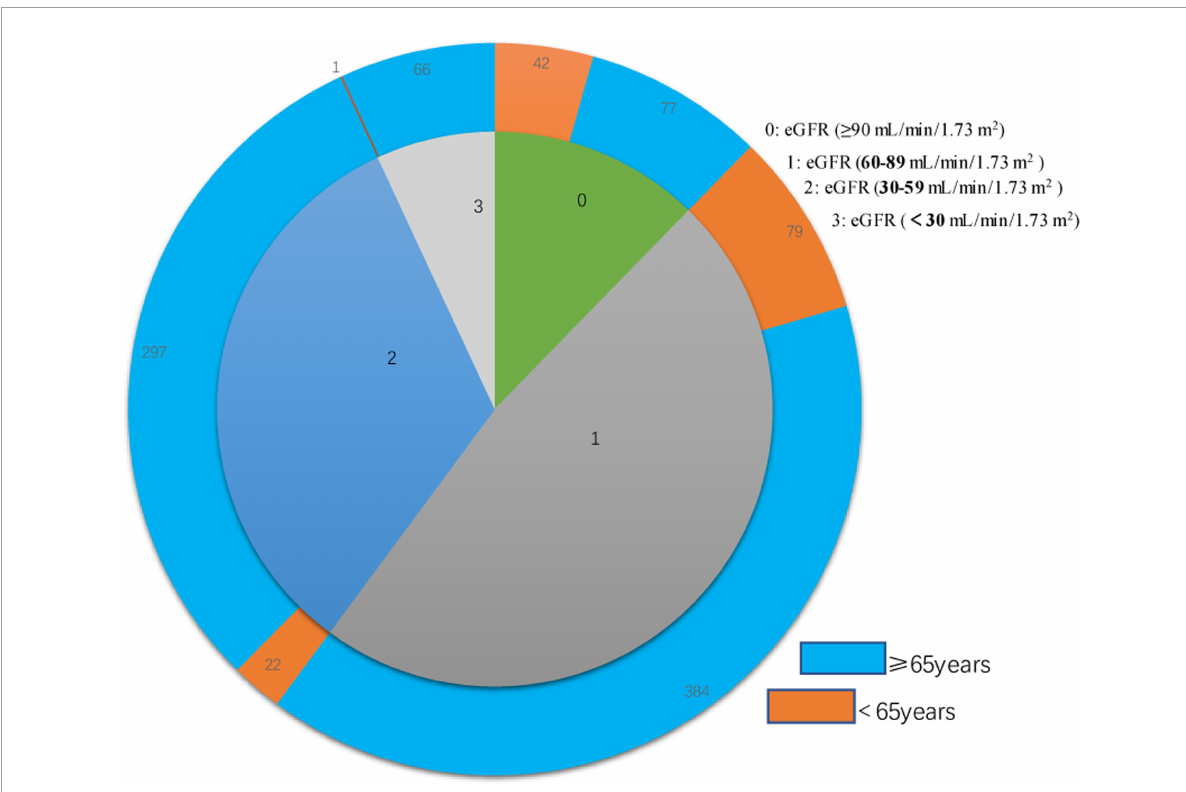
FIGURE1 Double layer pie chart showing the numbers of patients who were less than 65 years-old and 65 years-old or more (outer circle) in the eGFR-0, eGFR-1, eGFR-2, and eGFR-3 groups (inner circle). Estimated glomerular filtration rate (eGFR) groups are defined in Table 1